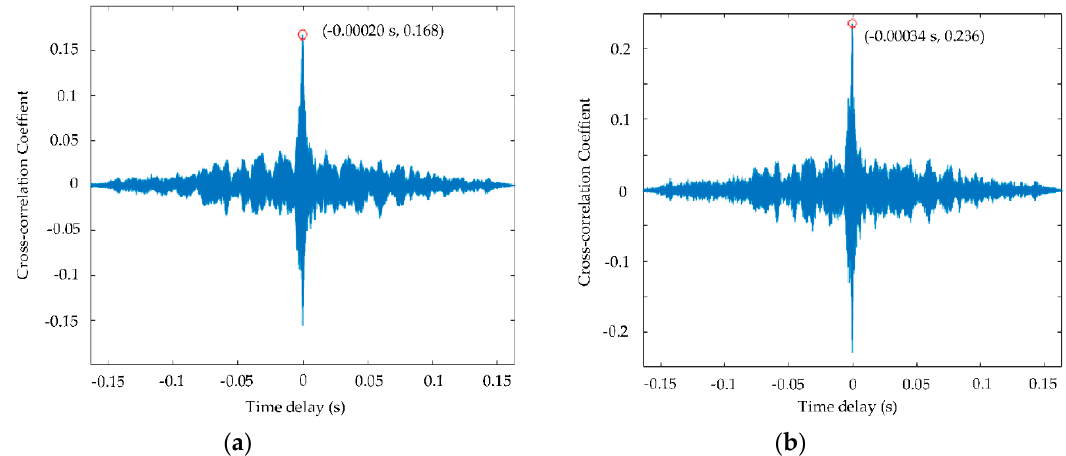
Figure 14. Cross-correlation coefficients (CCCs) obtained by two methods: ( a ) CCF location method, and ( b ) modified GCC location method.